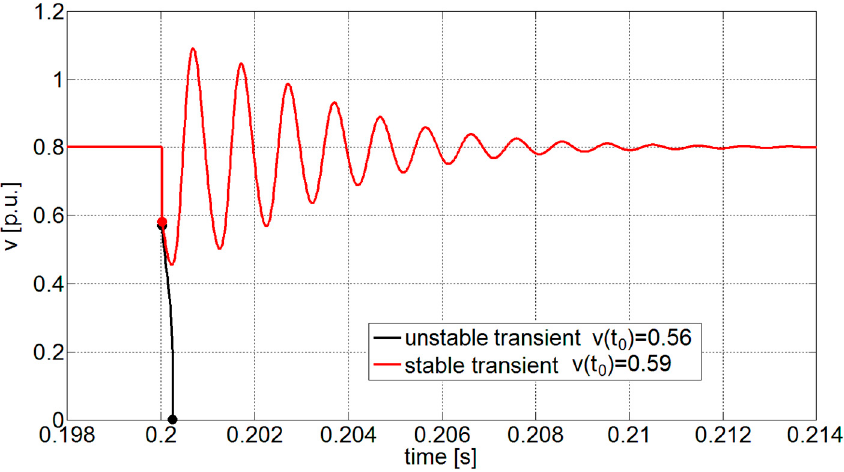
Appl. Sci. 2018 , 8 , x FOR PEER REVIEW Figure 4. Voltage transients due to a voltage impulse perturbation at t = 0.2 s.